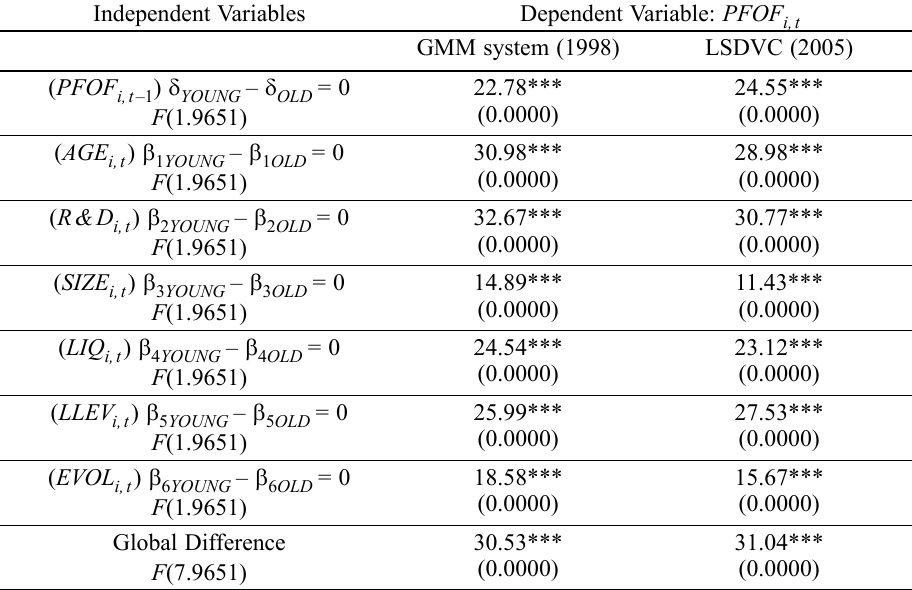
Table 7. Chow test – determinants of profitability – Young SMEs and Old SMEs Independent